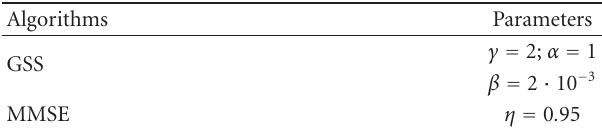
Table 1: Experimental parameters used in the noise suppression